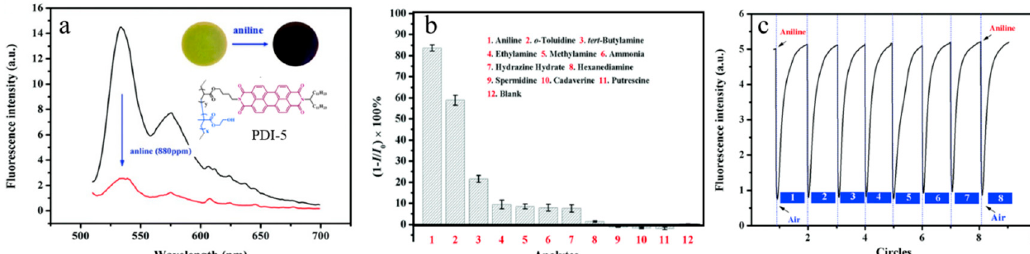
Figure 7. ( a ) Fluorescence spectra of a PDI-5 film deposited on silica gel plate before and after exposed to 880 ppm aniline vapor; inset shows the photographs taken from the same film under a 365 nm UV lamp before and after exposure to aniline vapor, visually indicating the effective fluorescence quenching; ( b ) Fluorescence quenching efficiency (1-I/I o ) measured over a PDI-5 film upon 5 s of exposure to the saturated vapor of various amines; ( c ) Fluorescence on/off response of a PDI-5 film upon 5 s of exposure to saturated vapor of aniline measured on the home-made platform ( λ ex = 490 nm) [65].